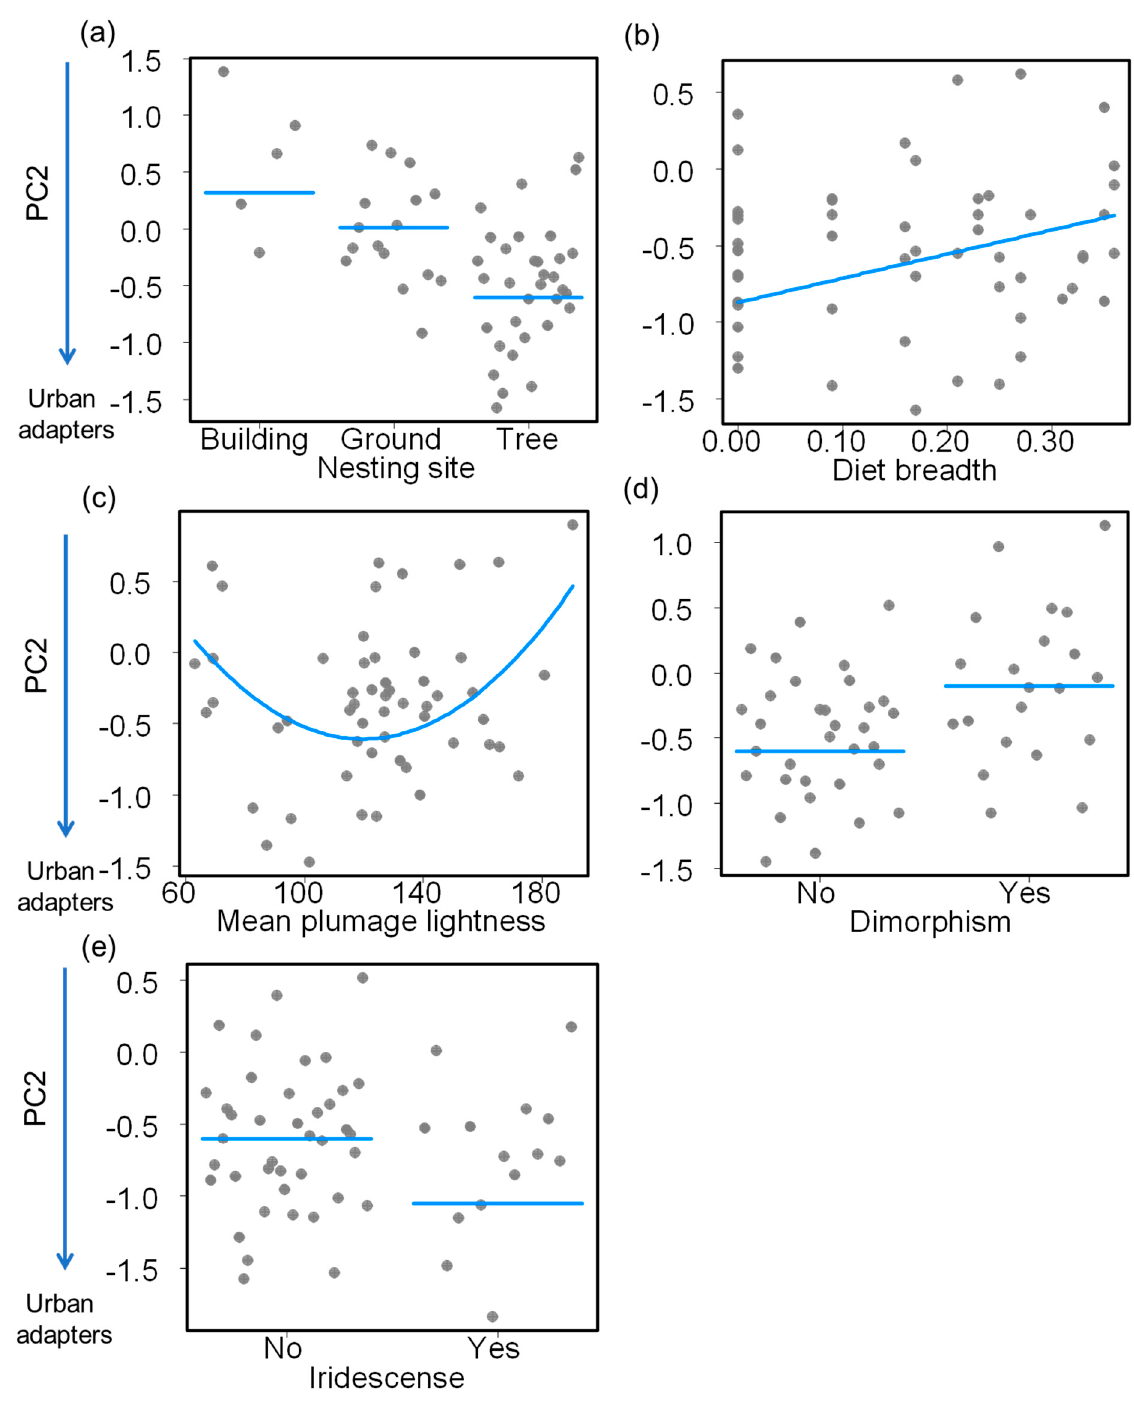
Figure 3. Relationship between the second principal component score values (PC2) of bird species and ( a ) nesting site, ( b ) diet breadth, ( c ) mean plumage lightness, ( d ) plumage dimorphism presence and ( e ) the presence of plumage iridescence. Negative PC2 score values are related to urban adapters. In ( a , d , e ) lines indicate mean values, whereas in ( b – c ) lines indicate the fit of the phylogenetic generalized least square model.